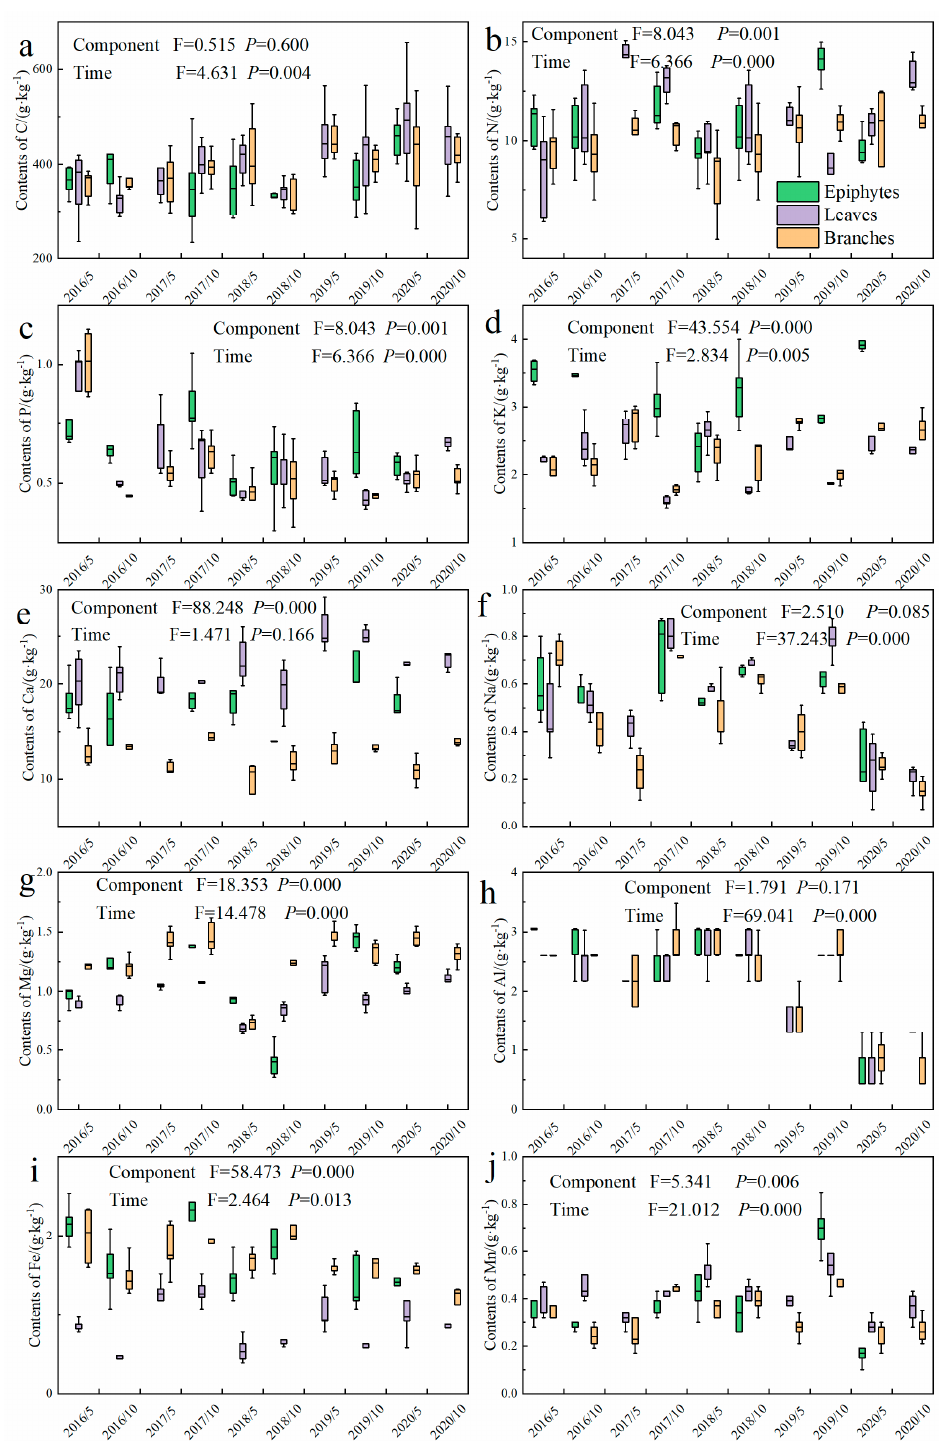
Figure 4. Litterfall element contents in A. faxoniana forest from 2016 to 2020. ( a ): The C contents of the litter; ( b ): the N contents of the litter; ( c ): the P contents of the litter; ( d ): the K contents of the litter; ( e ): the Ca contents of the litter; ( f ): the Na contents of the litter; ( g ): the Mg contents of the litter; ( h ): the Al contents of the litter; ( i ): the Fe contents of the litter; and ( j ): the Mn contents of the litter. The values represent the means ± SD; n = 45. Table 1. Correlation between the amount of litterfall and air temperature and precipitation.